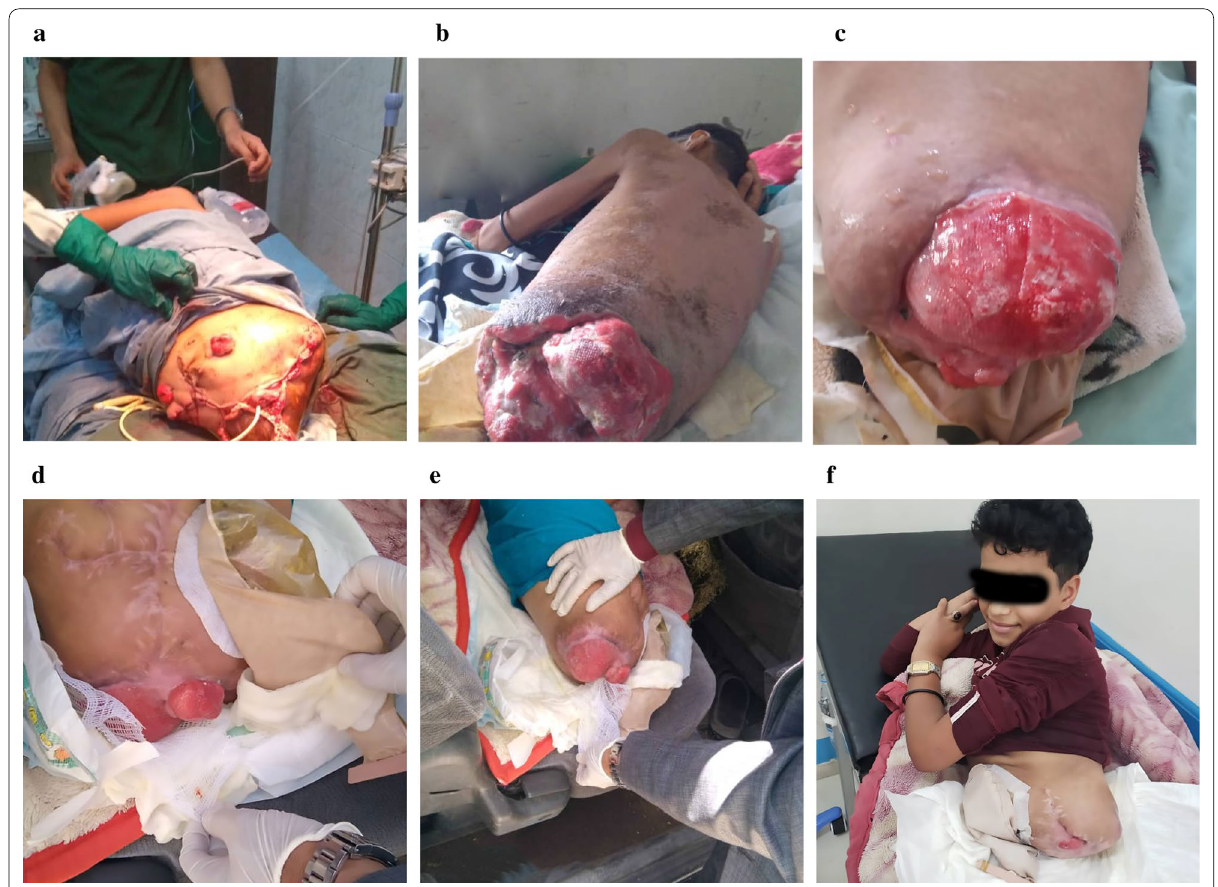
Fig. 2 a Postoperative clinical situation achieving primary closure of the wound with completed amputation of both lower extremities. b and c Clinical photographs showing an anterolateral thigh flap with progressive skin necrosis. d Clinical follow‑up 5 months after debridement of the remaining a gluteus myocutaneous flap; in the supine position, epithelialization was achieved. e In the lateral position, epithelialization was achieved. f Rehabilitation was started, along with the use of wheelchair